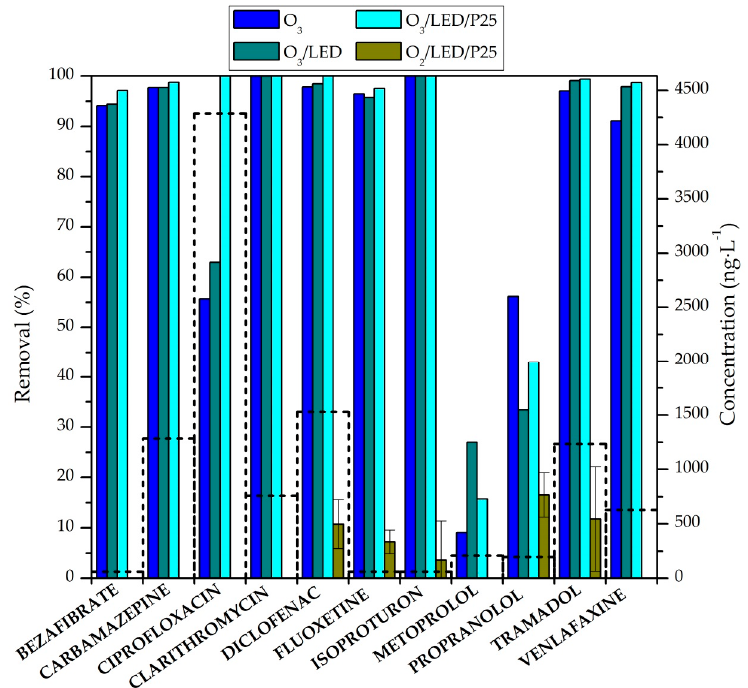
Figure 1. Removal of contaminants of emerging concern (CECs)s from wastewater 1 (WW1) (left axis, solid bars) and initial concentration of CECs (right axis, dotted bars) in different semi-batch experiments (ozonation (O 3 ), photolytic ozonation (O 3 / LED), photocatalytic oxidation (O 2 / LED / P25), and photocatalytic ozonation (O 3 /LED/P25)). Conditions: reaction time = 10 min; gas flow rate = 150 mL·min − 1 ; P25 loading (when applied) = 0.5 g·L − 1 ozone concentration (when applied) = 50 mg·L − 1 .